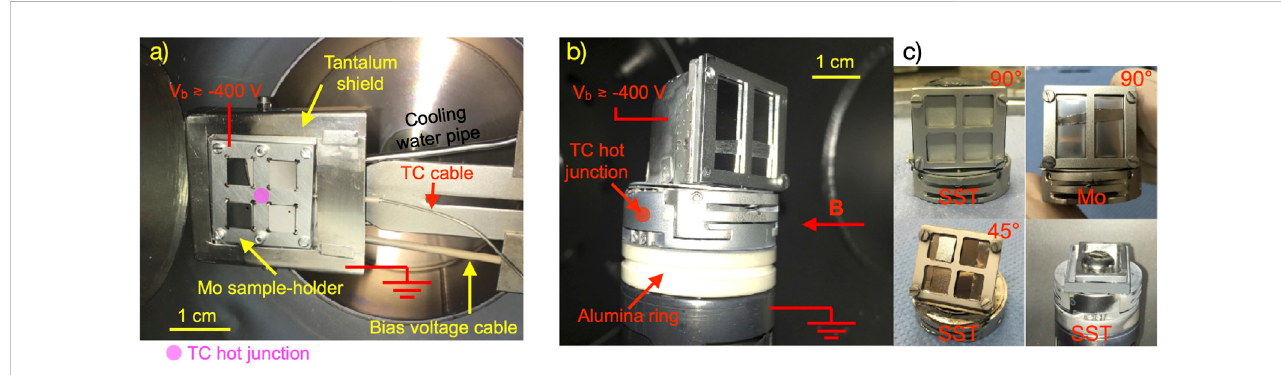
FIGURE 4 Photographsof:thecoldmanipulatorfromtheCF160quickaccessdoorofSExC (A) andthehotmanipulatorfromtheCF100quickaccessdoorofsector 4 (B) .Differentsamplecarrierheadsofthehotmanipulator (C) .Topandbottomleft:thecarrierheadsfornormaland45 ° exposureswiththeSSTholderwhich can accommodateup to four 1 × 1 cm 2 samples. Top-right: thecarrierhead for normal exposureswith theMo holder whichcan accommodateup to two 1 × 2 cm 2 samples. Bottom-right: SST horizontal carrier head with a SST tray, overall size of 20.4 × 18.4 mm 2 , and a liquid tin droplet in the